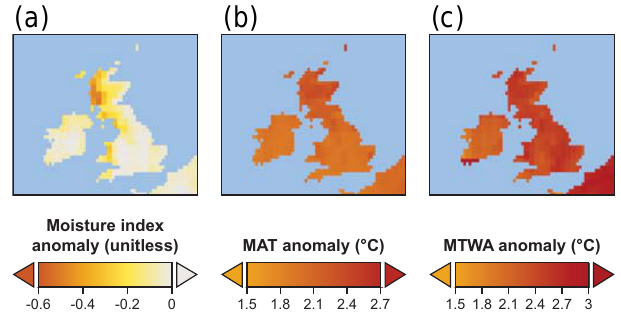
Figure 3. Average climate anomalies at 6ka from pollen-based reconstruction: (a) moisture index, (b) mean annual temperature (MAT), and (c) temperature of the warmest month